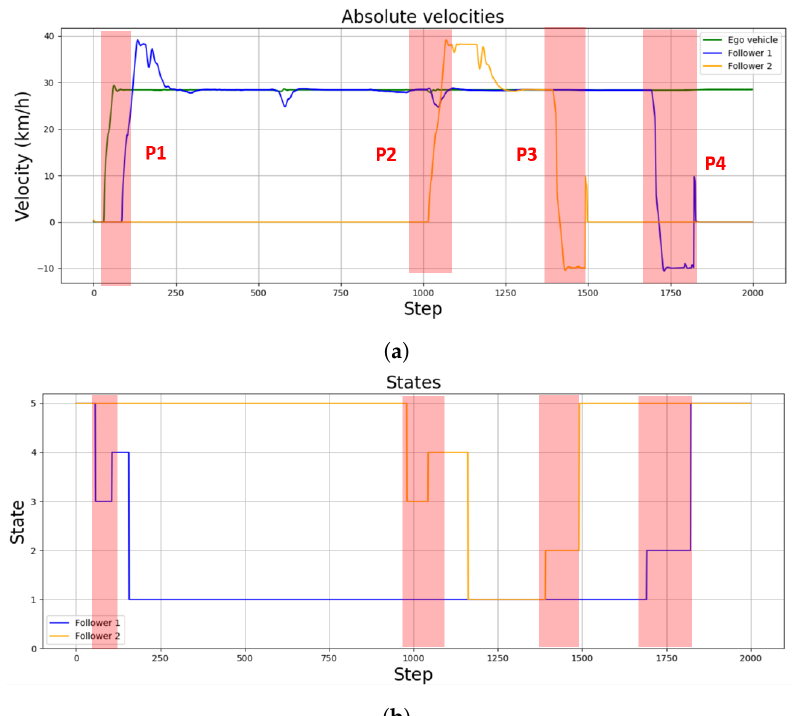
Figure 14. Velocities and states of the relocated vehicles during the use case. ( a ) represents the velocities of each vehicle. ( b ) represent the state of each vehicle: (1) Car following; (2) parking; (3) de-parking; (4) joining; (5) waiting. Parking and de-parking points are highlighted in